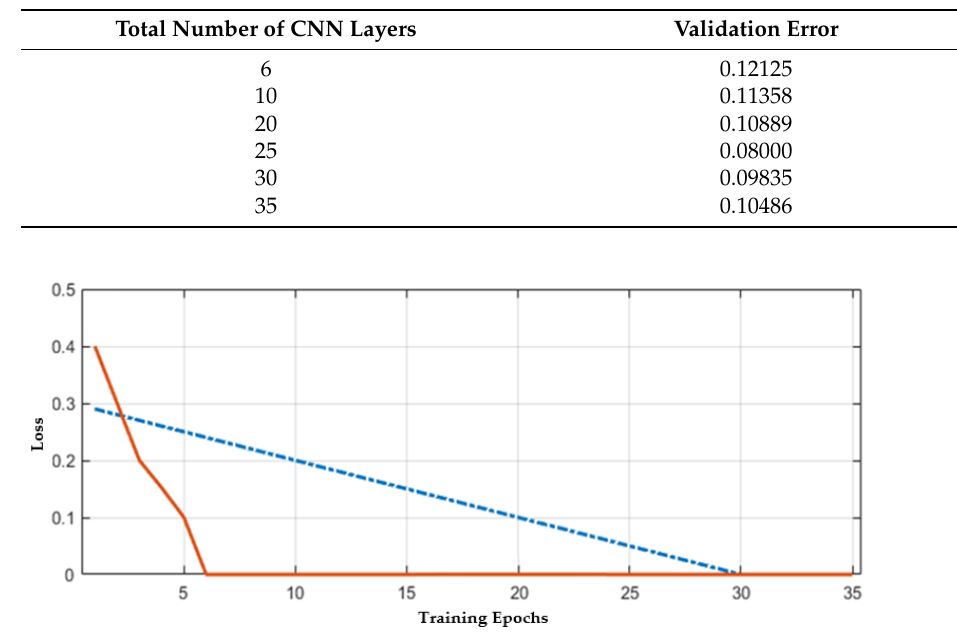
Figure 9. Accuracy with respect to loss. Table 5. Validation error for layers selection in the proposed CNN